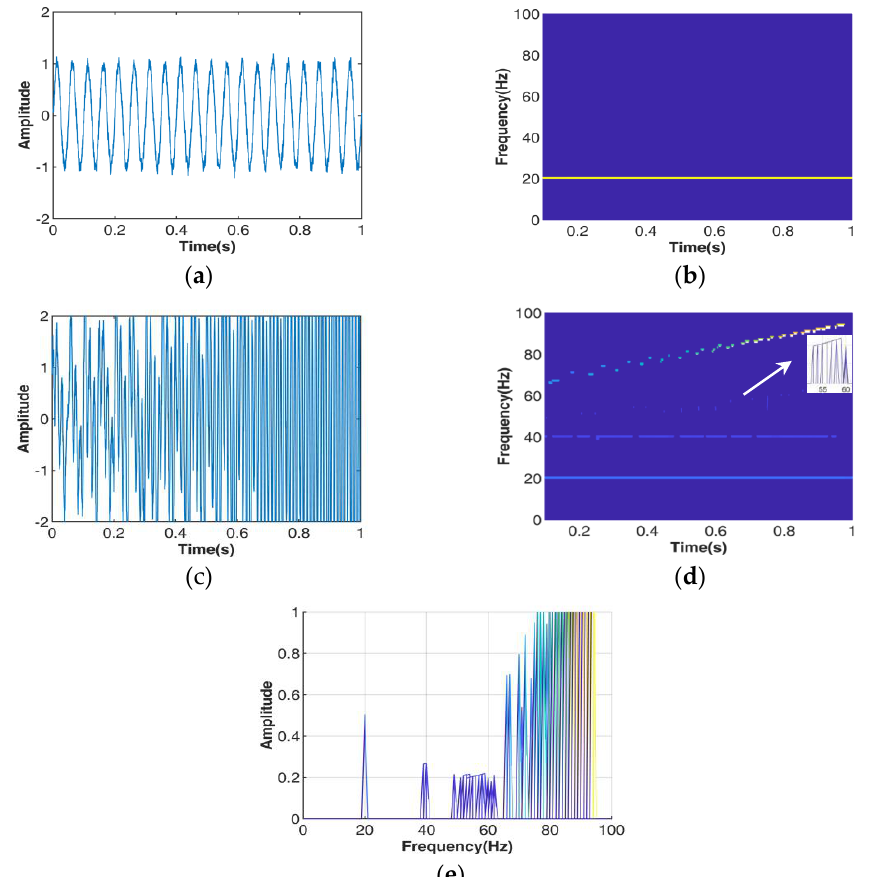
Figure 9. Comparison of rotor in both normal and unbalanced vibration states. ( a ) Time domain representation of rotor in normal state; ( b ) SEST time-frequency representation of rotor in normal state; ( c ) time domain representation of rotor unbalance vibration; ( d ) SEST time-frequency representation of rotor unbalance vibration; ( e ) SEST frequency spectrum of rotor unbalance vibration.